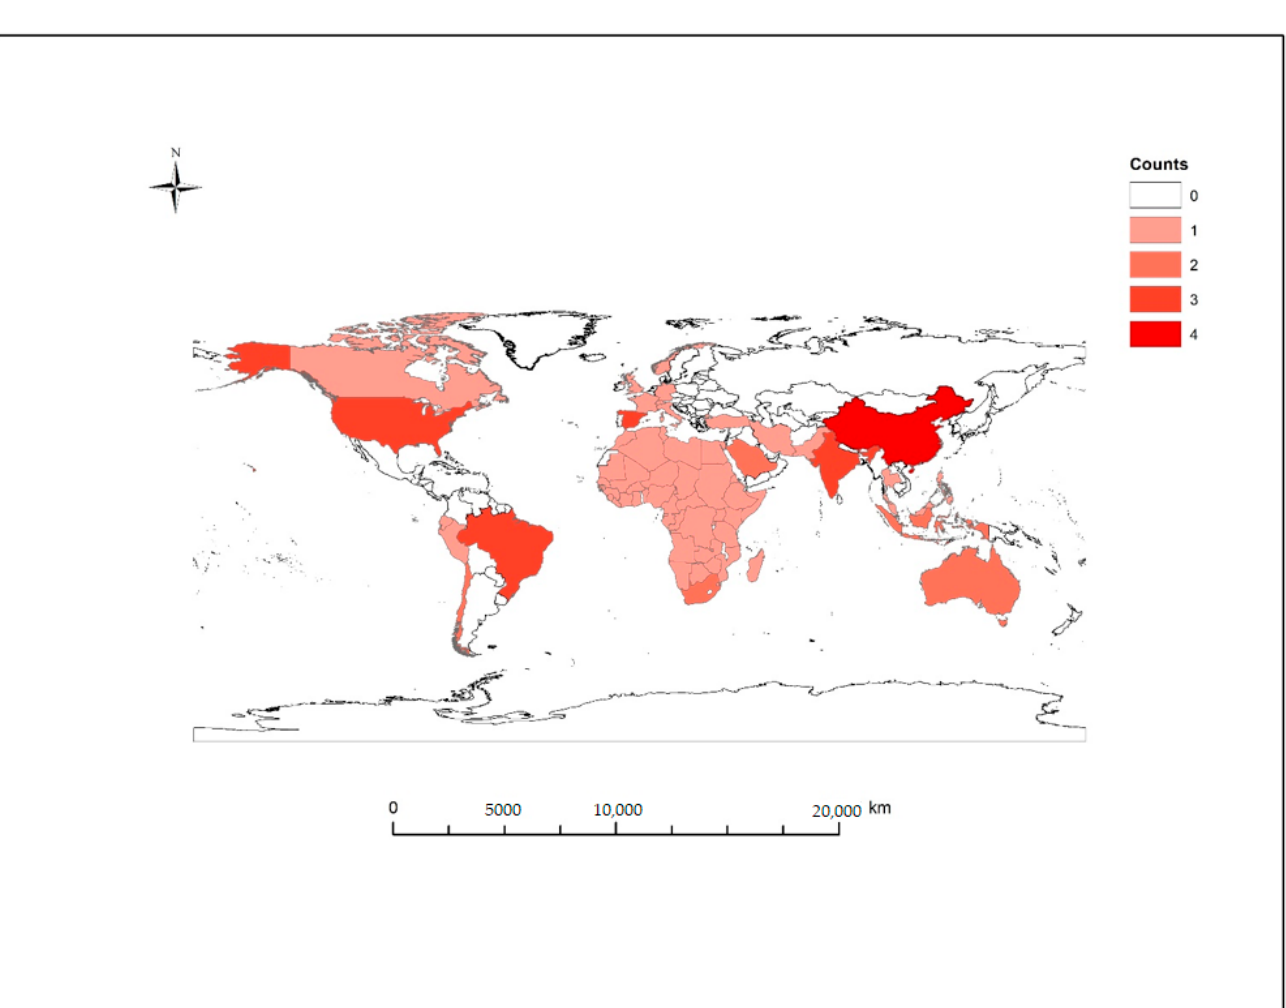
Figure 3. Geographical distribution of locations included in articles for review. (Three global studies of 166 countries, 185 countries and 100 countries were not shown).